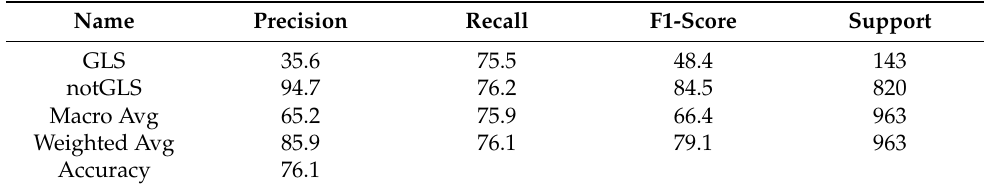
Table 11. Performance of GLS_net_noBackground upon the PV testing